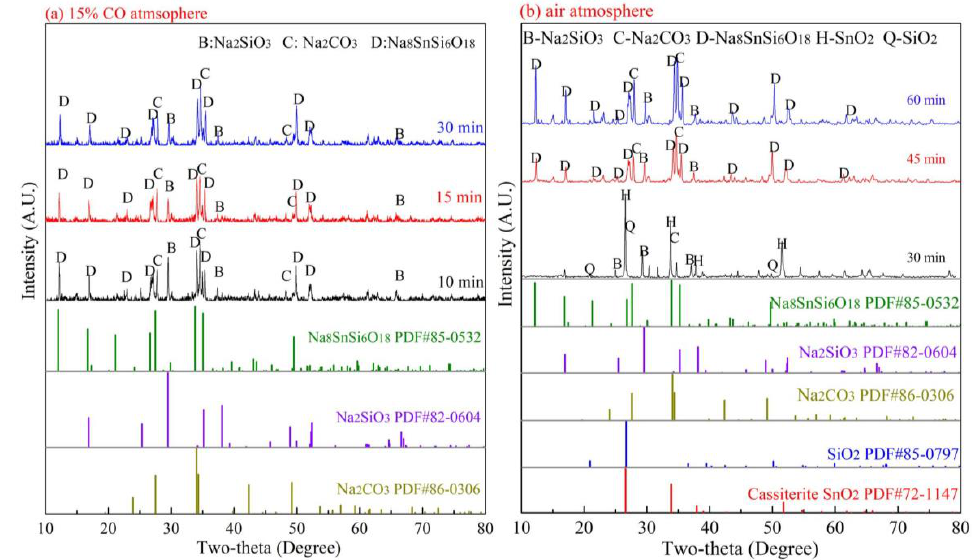
Figure 4. Effect of atmosphere on the formation of Na 8 SnSi 6 O 18 (at 875